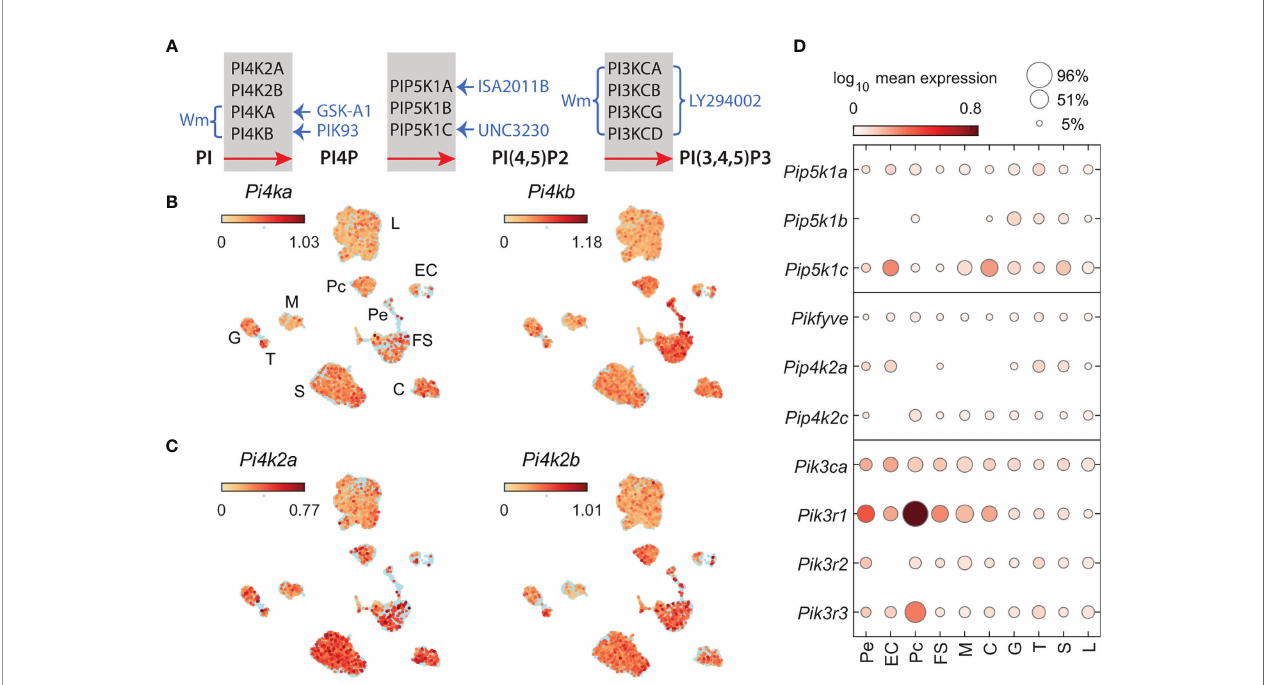
FIGURE 1 | Phosphatidylinositol kinases involved in the generation of PI4P, PI (4,5)P2, and PI (3,4,5)P3 and kinase inhibitors used in this study. (A) Inhibition of PIKs by drugs; braces and arrows indicate the enzymes inhibited by inhibitors (blue text). Wortmannin (Wm), a fungal metabolite, is a cell-permeable, irreversible inhibitor of phosphatidylinositol-4-kinases PI4KA and PI4KB in a micromolar concentration range (20) and phosphadidylinositol-3-kinases (PI3Ks) in a nanomolar concentration range (29). PI3KCs are also inhibited by LY294002 in a micromolar concentration range (30). PI4KA is inhibited by GSK-A1 (25) and PI4KB by PIK93 (31), both in a nanomolar concentration range. ISA2011B blocks PIP5K1A (26), whereas UNC3230 inhibits PIP5K1C (27). If not otherwise indicated, we used 10 µM Wm, 100 nM GSK-A1, 100 nM PIK93, 10 µM ISA2011B, 1 µM UNC3230, and 1 and 50 µM LY2394002. Enzymes involved in PI5P production, PIKfyve, a FYVE fi nger-containing PIK, and PI5P-dependent PI (4,5)P2 production, PIP4K2, phosphatidylinositol-5-phosphate 4-kinases type-2, and their inhibitors, are not shown. (B, C) The expression pattern of PIK genes in scRNAseq of freshly dispersed rat pituitary cells. Uniform manifold approximation and projection (UMAP) plots showing the expression of P4ka and Pi4kb (B) and Pi4k2a and Pi4k2b (C) in pituitary cells: L, lactotrophs; G, gonadotrophs; T, thyrotrophs; S, somatotrophs; C, corticotrophs; M, melanotrophs; FS, folliculostellate cells; Pe, pericytes; Pc, pituicytes; and EC, endothelial cells. (D) , Cell-type-speci fi c expression of Pip5k1a-c (top panel); Pikfyve, Pip4k2a, Pip4k2c (middle panel); Pik3ca, Pik3r1, Pik3r2 , and Pik3r3 (bottom panel), shown as mean expression level (color code) and percentage of pituitary cell types expressing these genes (area of